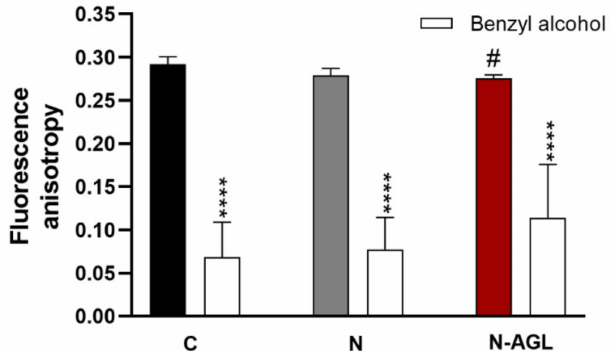
Figure 5. Plasma membrane fluidity measured by fluorescence anisotropy in living brain endothelial cells treated with non-targeted (N) or ascorbic acid-glutathione-leucine-targeted (N-AGL) nanoparti- cles and membrane fluidizer benzyl alcohol (30 mM). Values presented are means ± SD. Statistical analysis: two-way ANOVA, Bonferroni posttest. # p < 0.05, all groups were compared to medium treated control (C); **** p < 0.0001, compared to first column of each group, n =